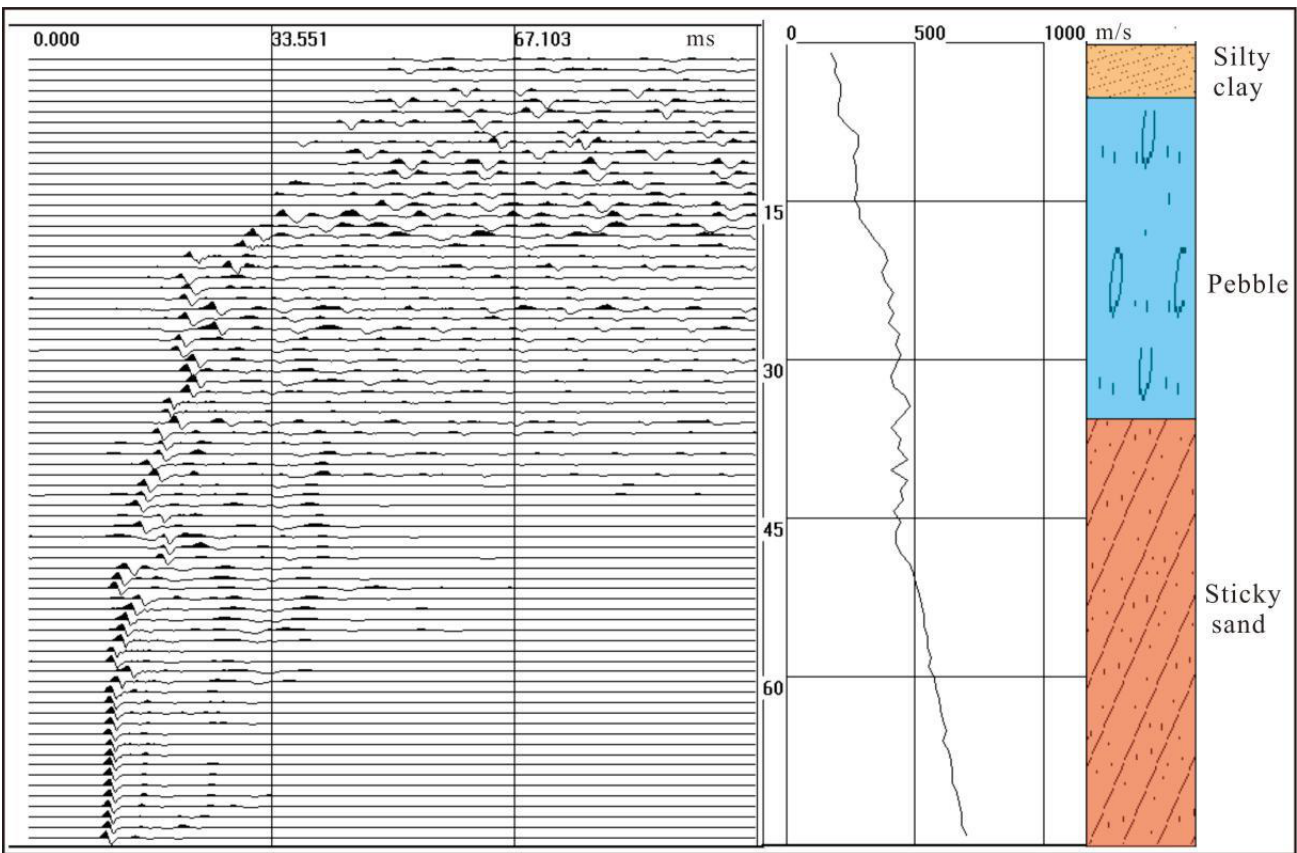
Figure 4. The wave velocity test results of typical drilling holes.